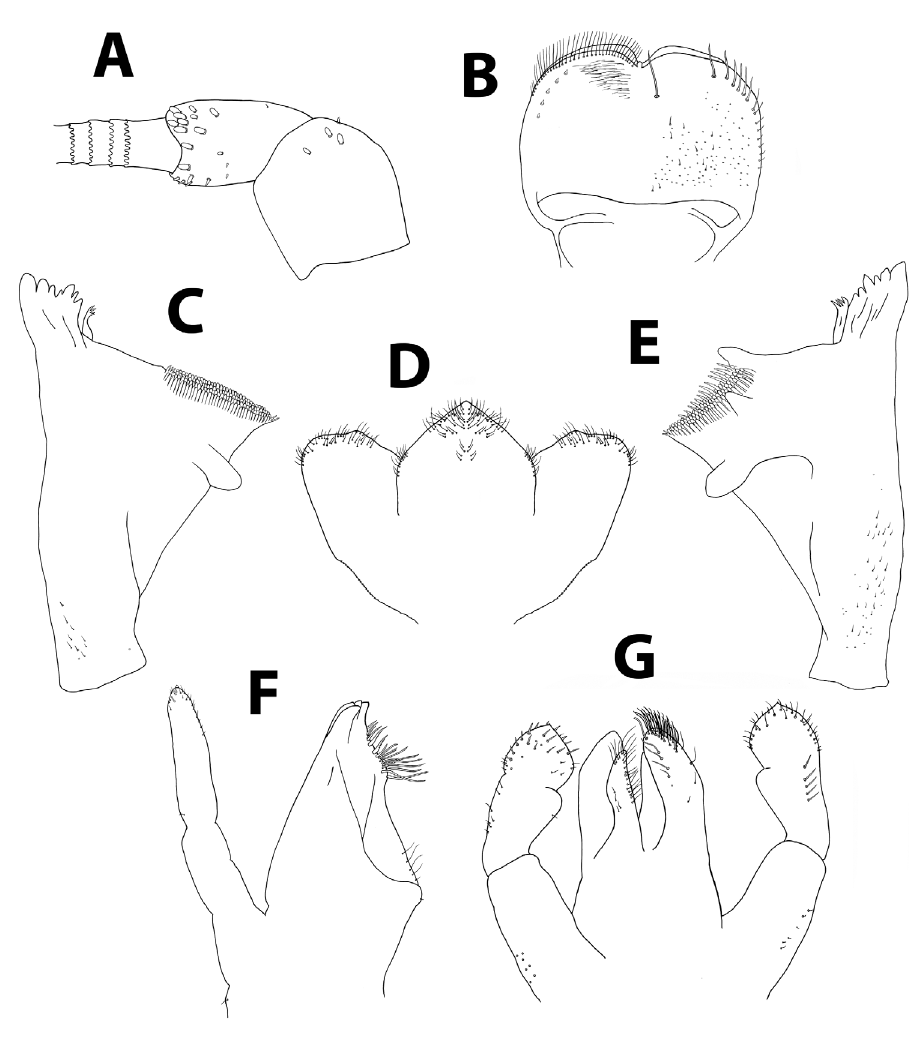
Figure 12. Baetis noa sp. n., nymph. A antennal scape, pedicel and first flagellomeres B labrum (left, ventral; right, dorsal) C right mandible D hypopharynx E left mandible F maxilla G